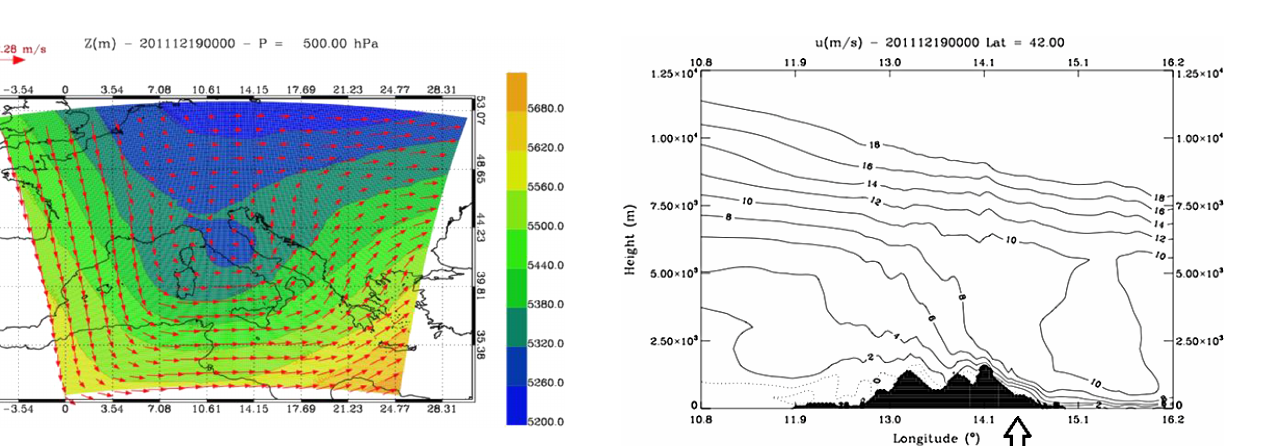
Figure 3. Geopotential height and wind vectors at 500hPa on 19 December 2011 at 00:00UTC. A cut-off (5320m) is apparent over central Italy.